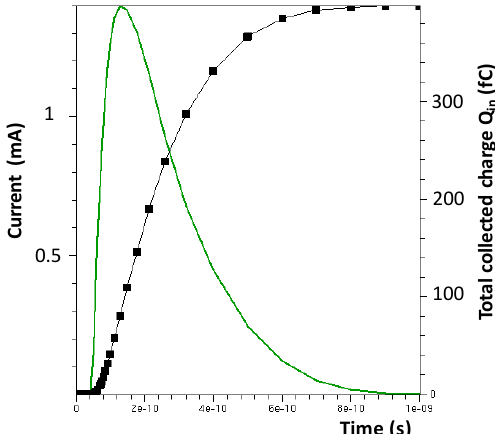
Fig. 19. Current at the bottom contact of the pixel (green curve) and corresponding total collected (black curve) versus time.